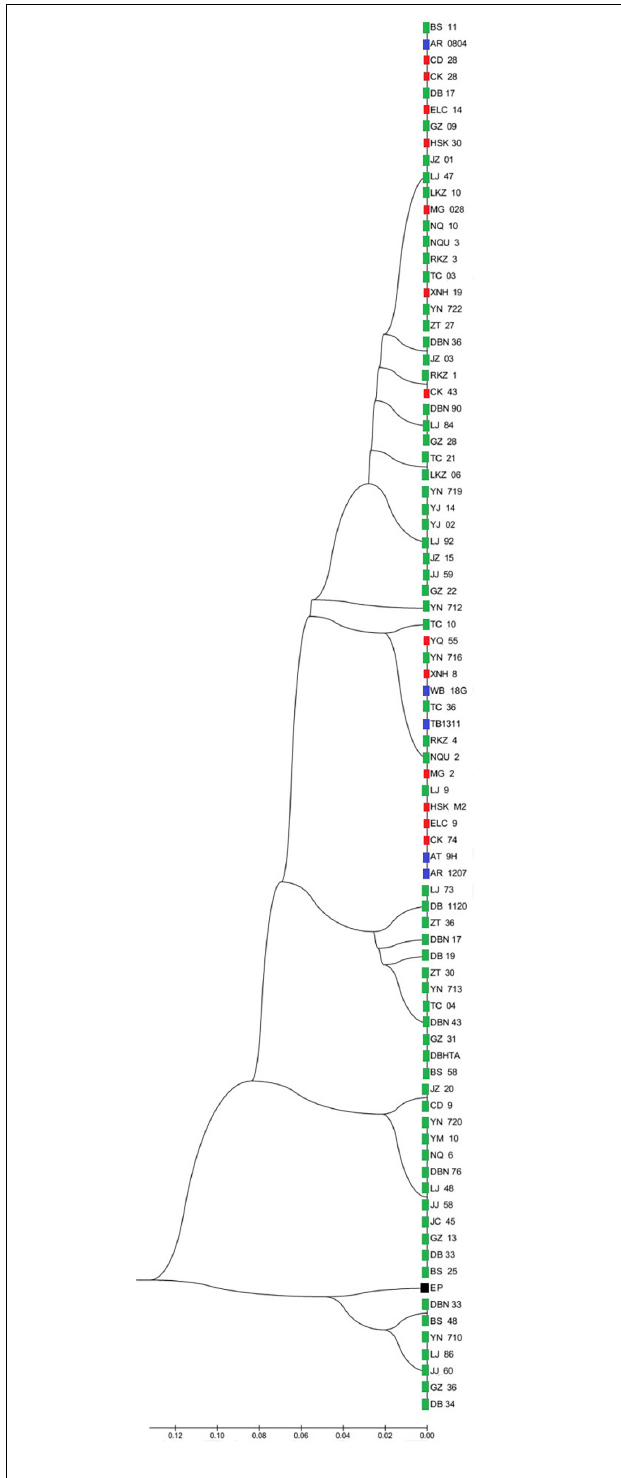
FIGURE 2 | UPGMA tree for all individuals constructed with 14 Y-chromosome SNPs. Individuals from the same breed clustered in one clade were represented by only one sample. Blue indicates introduced breeds; green, southern horses; red, northern horses; and black, Przewalski’s horse. Specific sample information and sample locations of distribution are provided in Supplementary Table S5 and Supplementary Figure S1